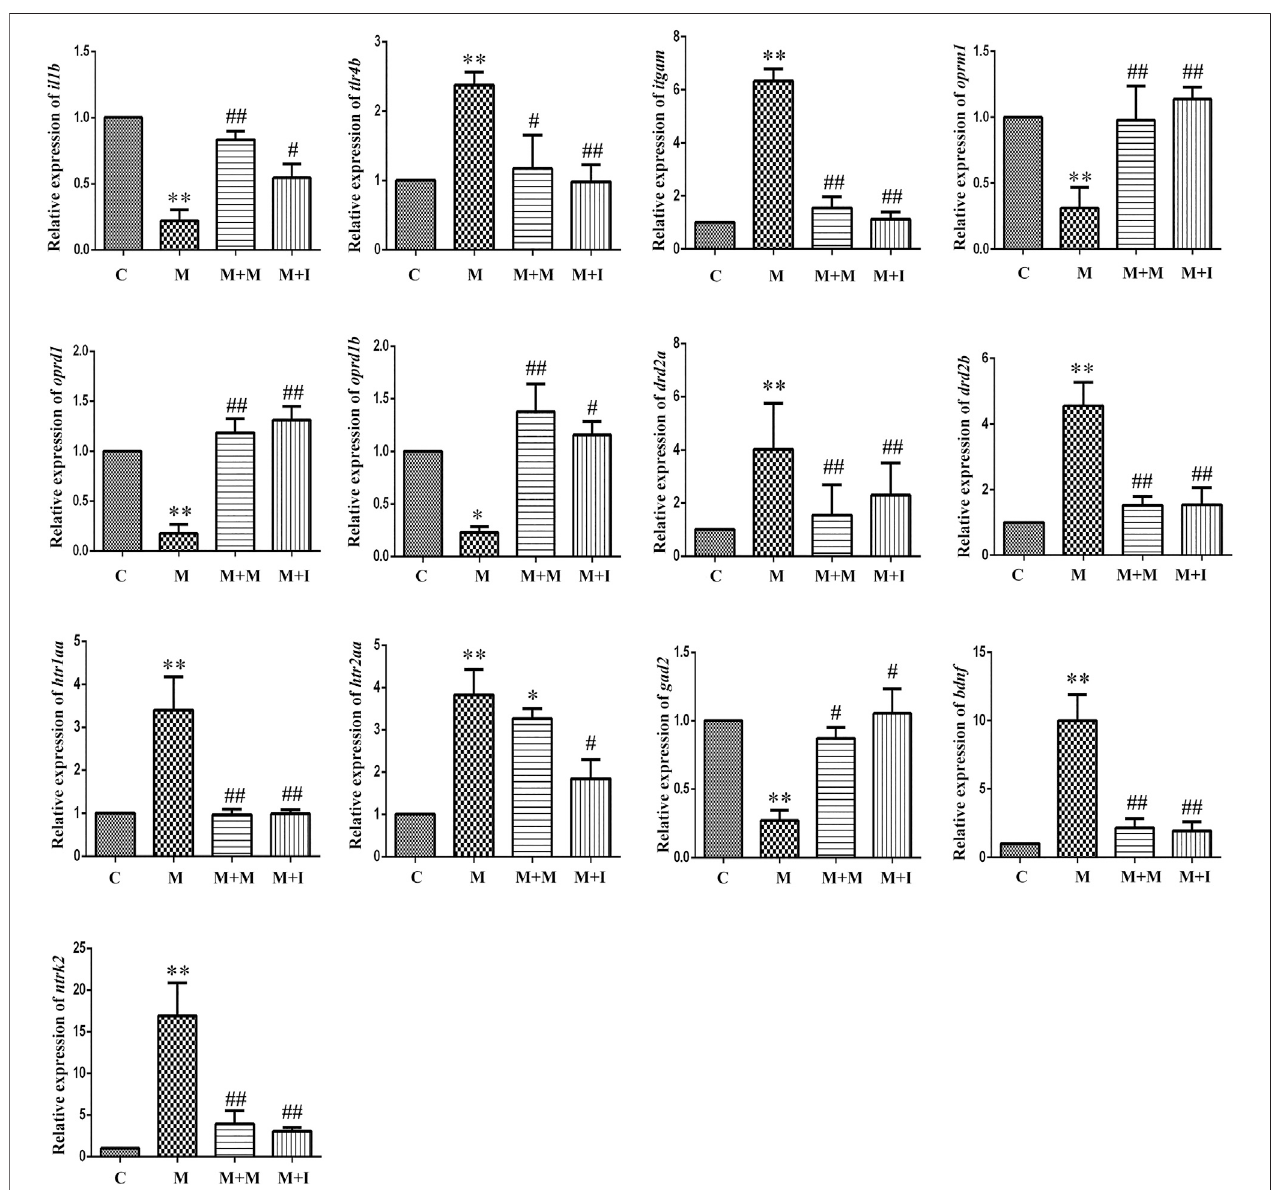
FIGURE8| qPCRanalysisof il1b , tlr4b , itgam , oprm1 , oprd1 , oprd1b , gad2 , drd2a , drd2b , htr1aa , htr2aa , bdnf ,and ntrk2 expressioninthezebra fi shbrain( n (cid:2) 3). * p < 0.05,** p < 0.01 vs theCgroup; # p < 0.05, ## p < 0.01 vs theMgroup.C:controlgroup;M:morphinegroup;M+M:morphine+methadonegroup;M+I:morphine+ isorhynchophylline